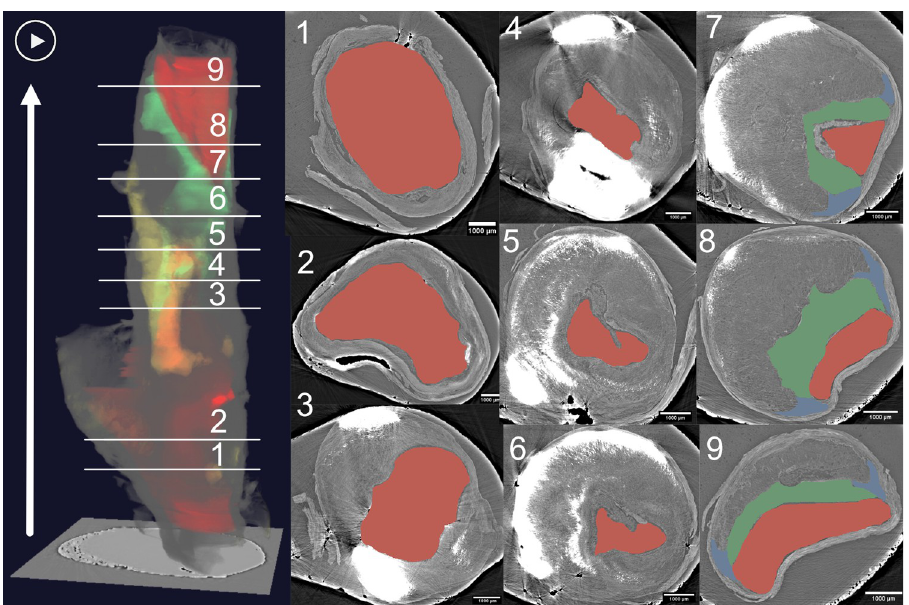
Fig 7. Irregular lumen (marked in red) and variation of fibrous cap thickness (marked in green) with 3D rendering. To the left is the 3D volume of a plaque with the calcifications, lumen, and fibrous cap segmented and highlighted with yellow, red, and green. The arrow indicates the direction of the blood stream. To the right, nine different axial planes with the lumen highlighted with red are shown to convey the lumen’s variation along the plaque length. The axial planes also show levels with different thickness of the fibrous cap (green) and the different shapes of the shoulder region (blue). In the axial planes, the calcifications are seen as white areas since the micro-calcifications were easier to see without the segmentation and yellow highlight. "Play" symbol: movie material showing the 3D rendering of the full plaque, with the lumen and fibrous cap segmented and highlighted (S10 Movie in S1 File). Plaque ID 2 in S1 Table in S1